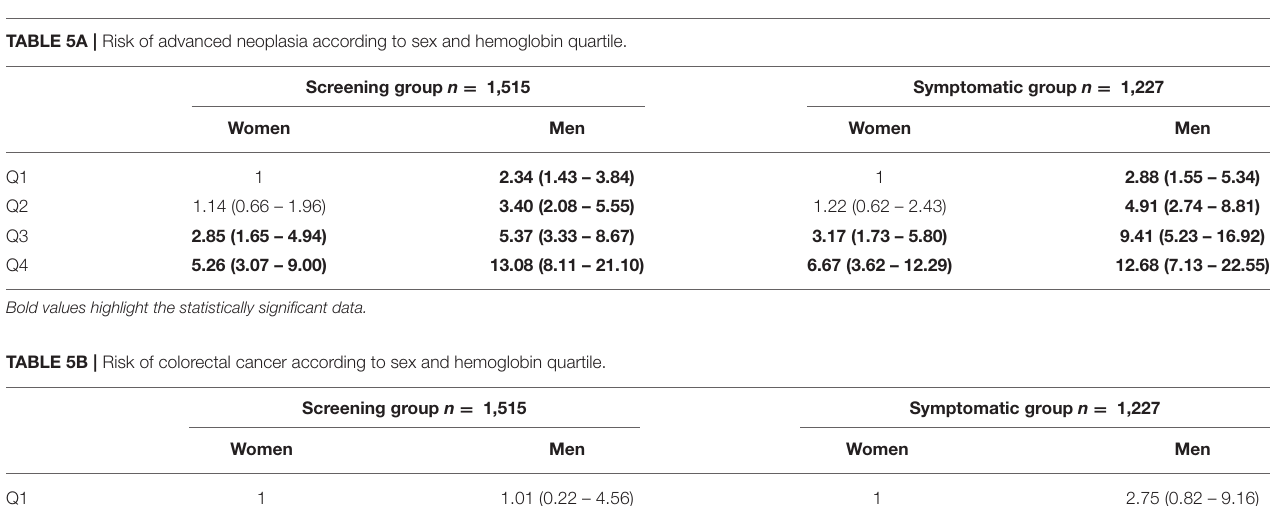
different locations within each group and between groups. FIT screening group both for left- and right-sided AN. Patients in the higher fecal hemoglobin concentration than those with right- sided AN ( p = 0.034). The risk of AN based on quartiles was